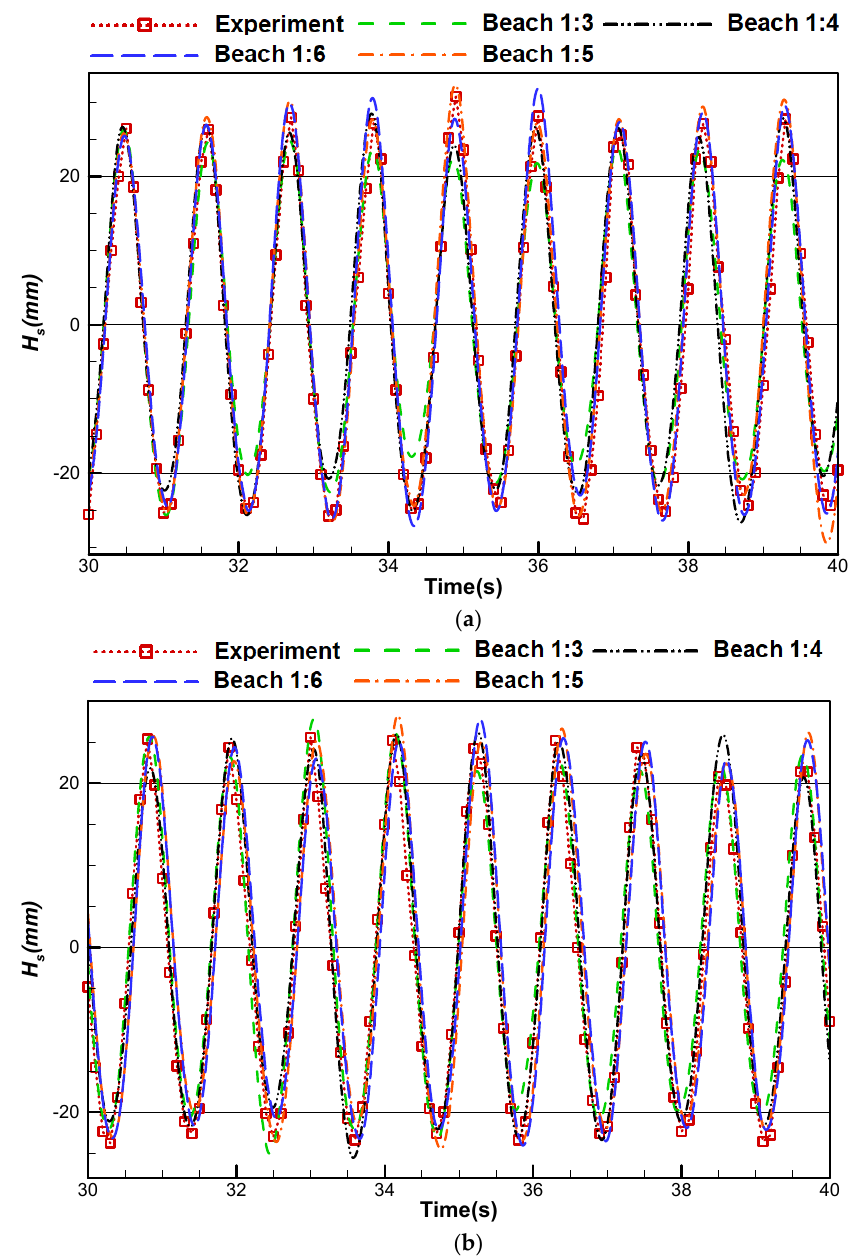
Figure 23. Wave height of case 3 for different beach slopes at a distance of ( a ) 3 m and ( b ) 5 m from the flap.